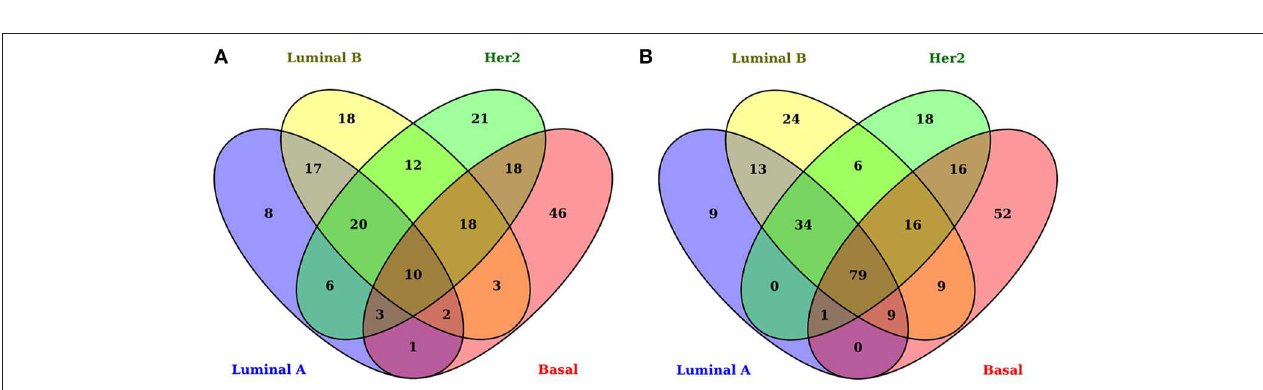
FIGURE 2 | Differentially expressed genes associated with metabolism in breast cancer molecular subtypes. In these Venn diagrams, each ellipse corresponds to the DEGs appearing in each subtype. The left set (A) corresponds to overexpressed genes and the right set (B) to underexpressed genes. The number inside each subset represents the number of genes appearing in each subset. Notice that the center of both figures corresponds to the common DEGs for all subtypes. There are only 10 overexpressed shared genes, while, for the underexpressed subset, 79 genes appear.